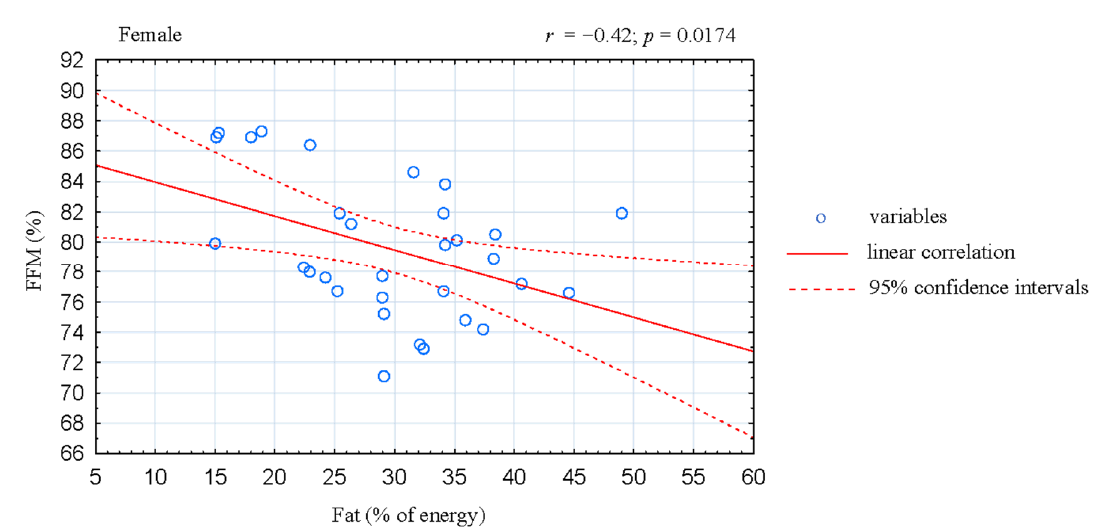
Figure 1. Correlation between dietary fat intake and fat-free mass (FFM) in female CrossFit-trained individuals.